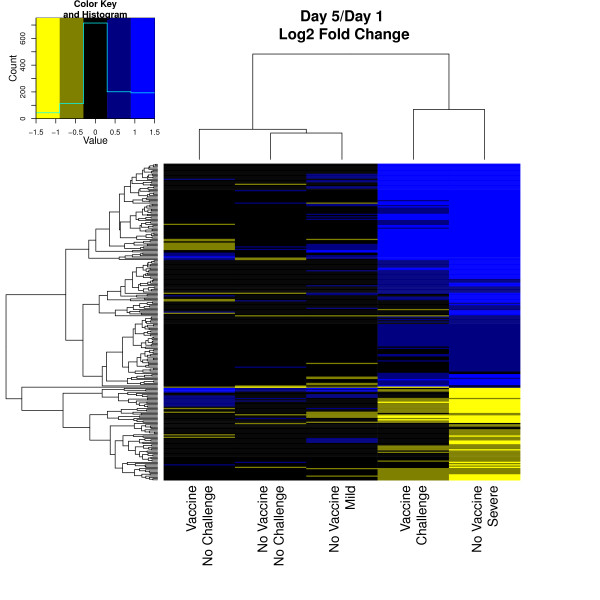
Heatmap comparison of day 1 and day 5. Visual representation of log2 fold change differences for all treatment groups between day 1 and day 5. Genes included were significant in at least one contrast presented (q-value < 0.05). Positive fold change indicates greater expression on day 5.